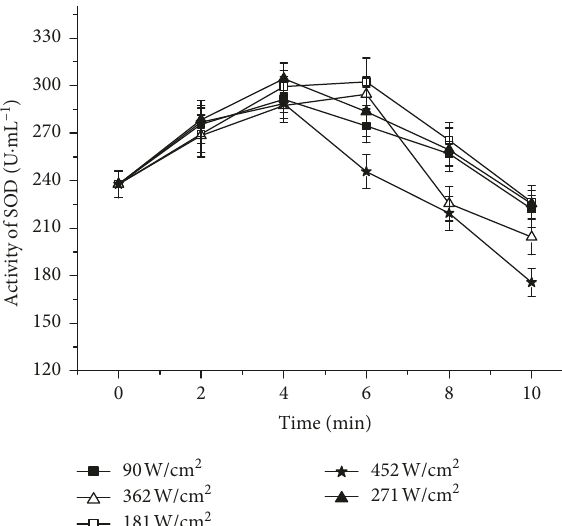
Figure 5: Effects of ultrasound processing on HMF of bayberry